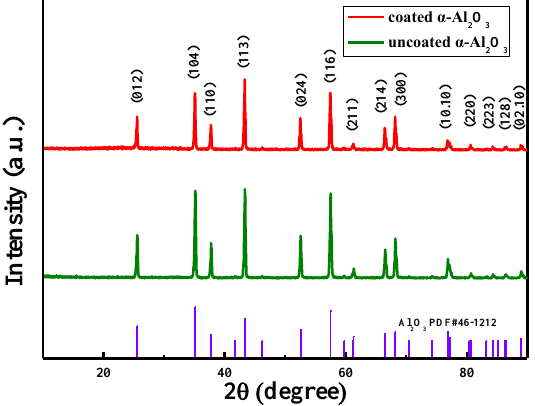
Figure 4. X-ray di ff ractometry (XRD) patterns of coated and uncoated α -Al 2 O 3 Figure 4. X-ray diffractometry (XRD) patterns of coated and uncoated α-Al 2 O 3 .